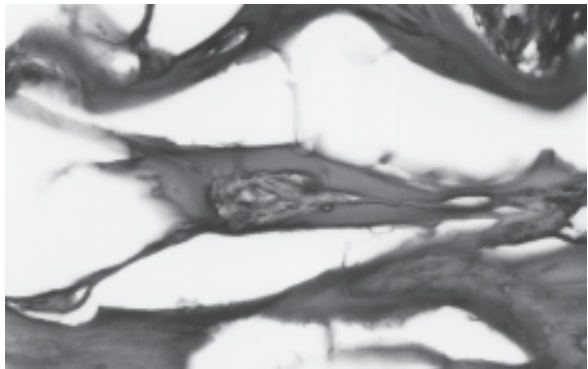
FIGURE 7 - BG, 60 days. Lamellar bone trabeculae surrounding the spaces filled with glass are thicker. Inside some spaces, a structure remaining from the implanted material (A) may be observed amidst the bone tissue, besides some thin bone septa. Bone growth can be observed inside the granule (B). HE. Magnification 400x